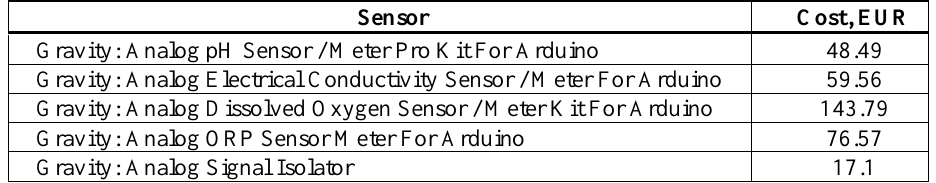
Table 3. Sensors used in the water quality monitoring device